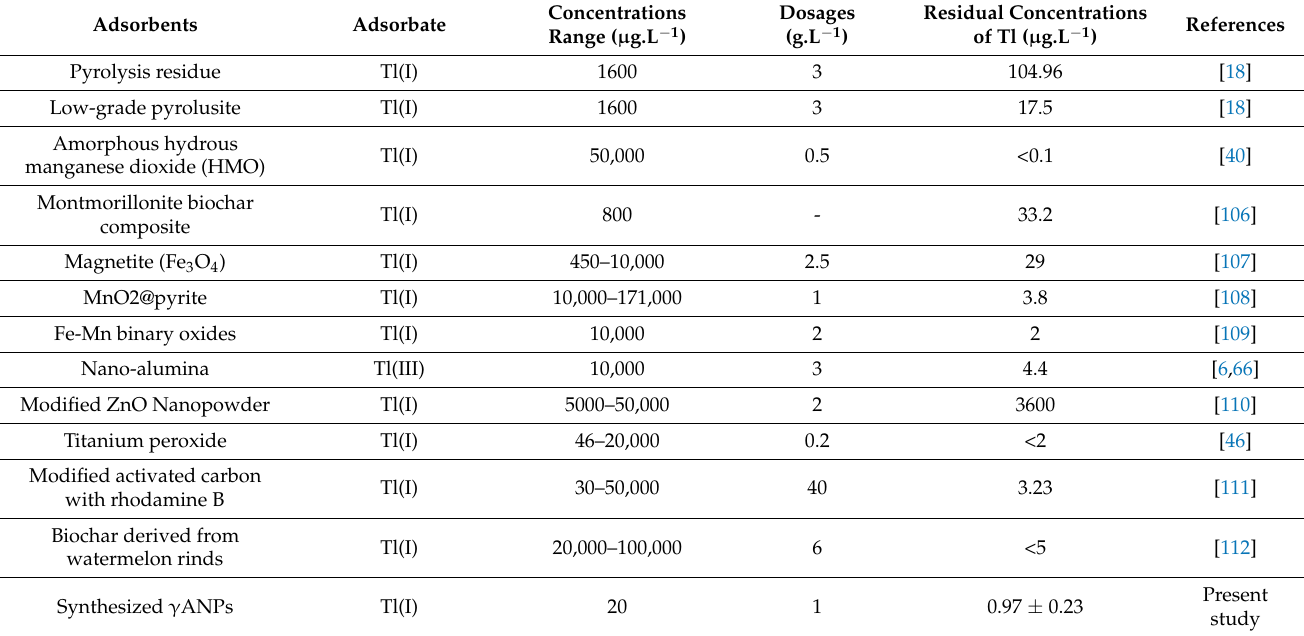
Table 3. Comparison of the present results with those reported in